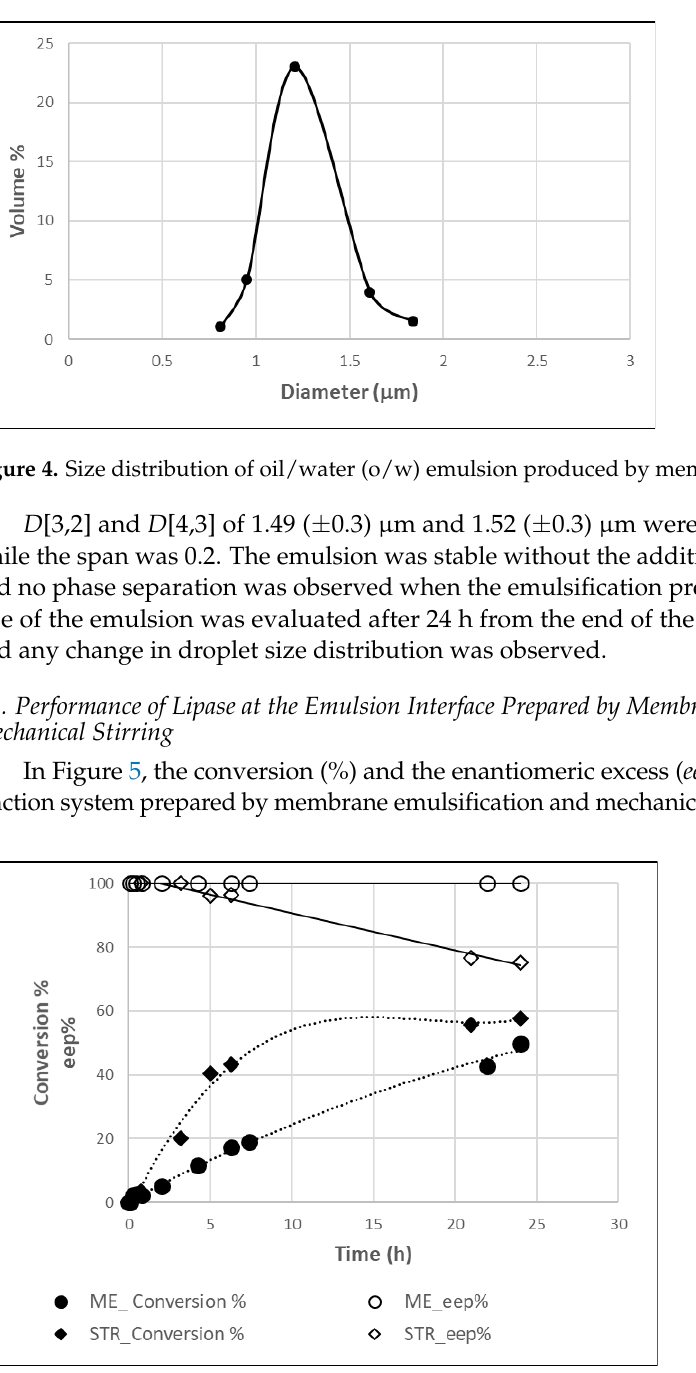
Figure 5. Time course of conversion and enantiomeric excess of the emulsion bioreaction carried out using the lipase distributed at the oil/water interface by membrane emulsification (ME) and mechanical stirring in a stirred tank reactor (STR).